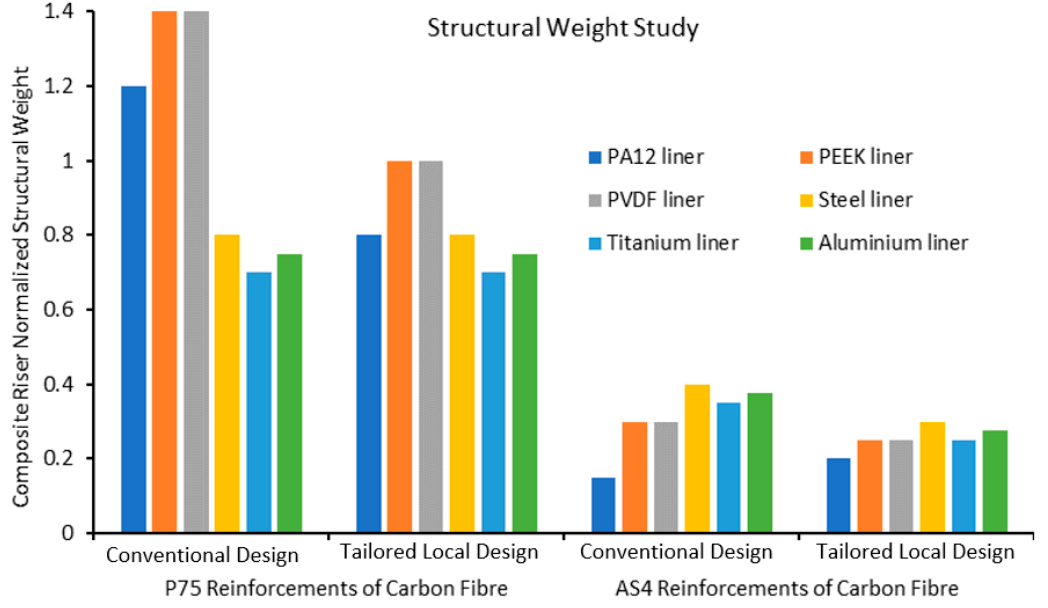
Figure 19. Comparative study at optimized angled plies for normalized structural weight.